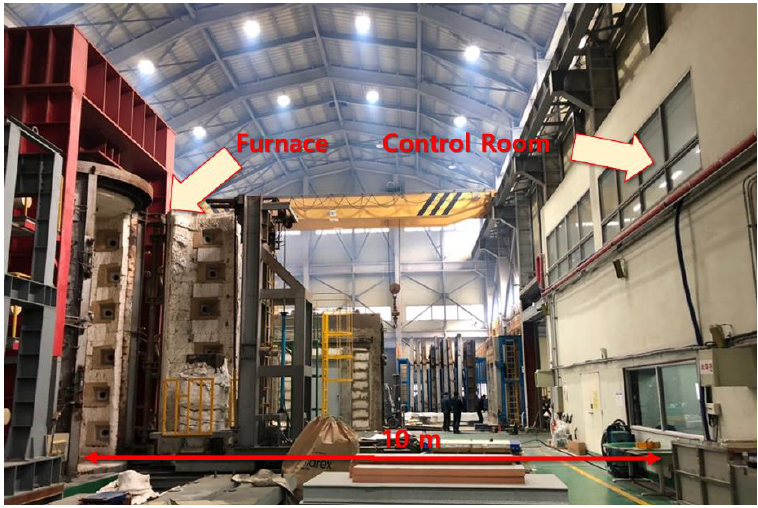
Figure 6. Experimental radio environment in the laboratory; a transmitter antenna is 1 m above the ground and a receiver is located in the control room.